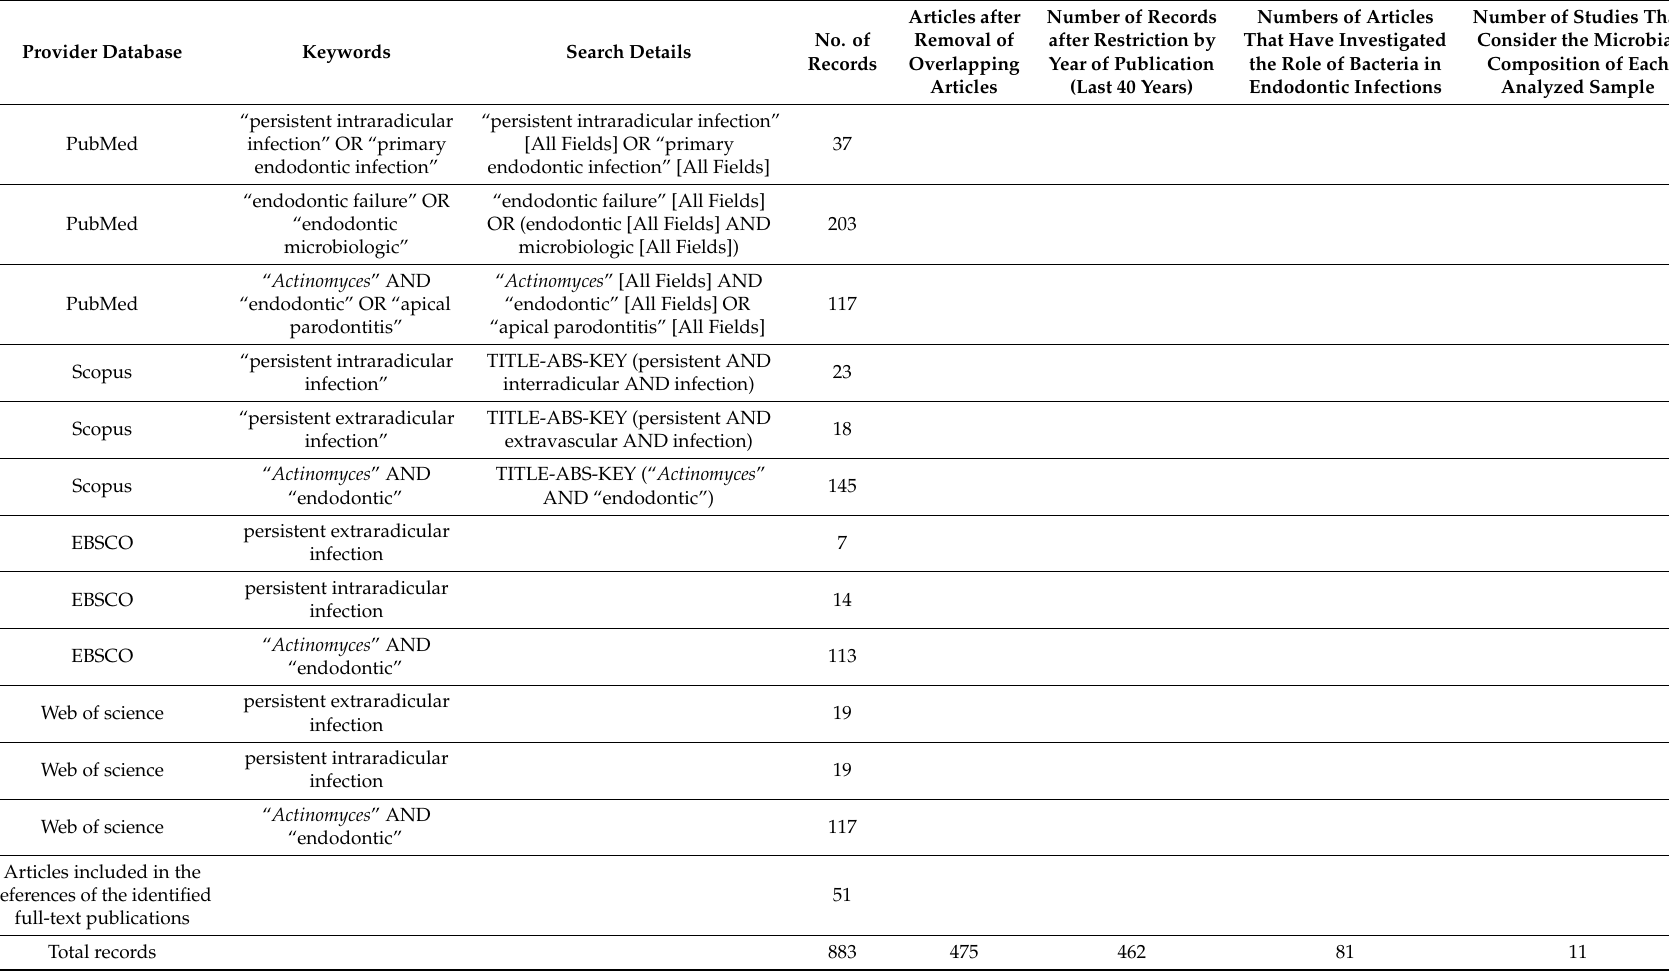
Table 1. Complete overview of the search methodology. The overlaps were removed using EndNote 8 software. Records identified by databases: 883; records selected for quantitative analysis: